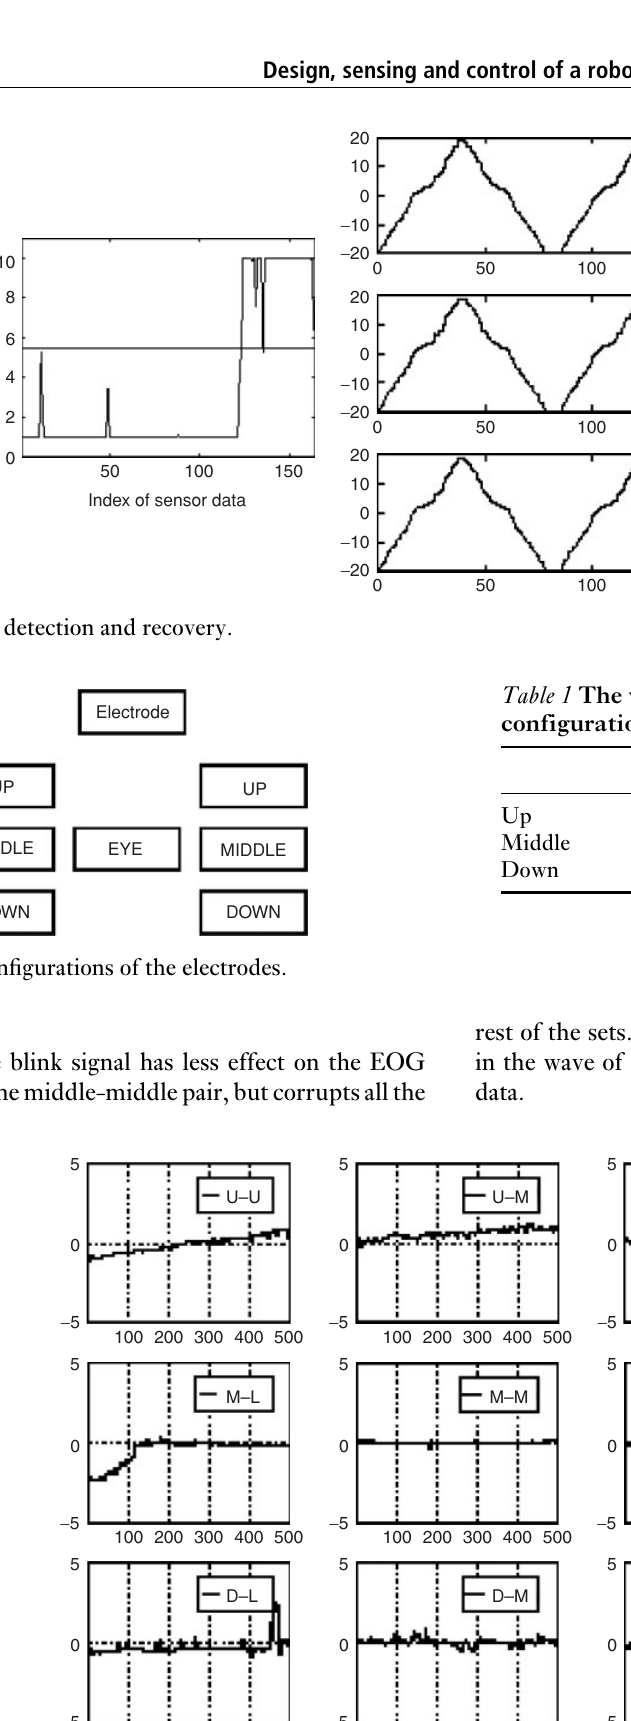
Figure 20 The baseline EOG to detect eye movement with different electrode configurations. U: up, D: down, M: middle. The subject is asked to focus on a point at the centre of the